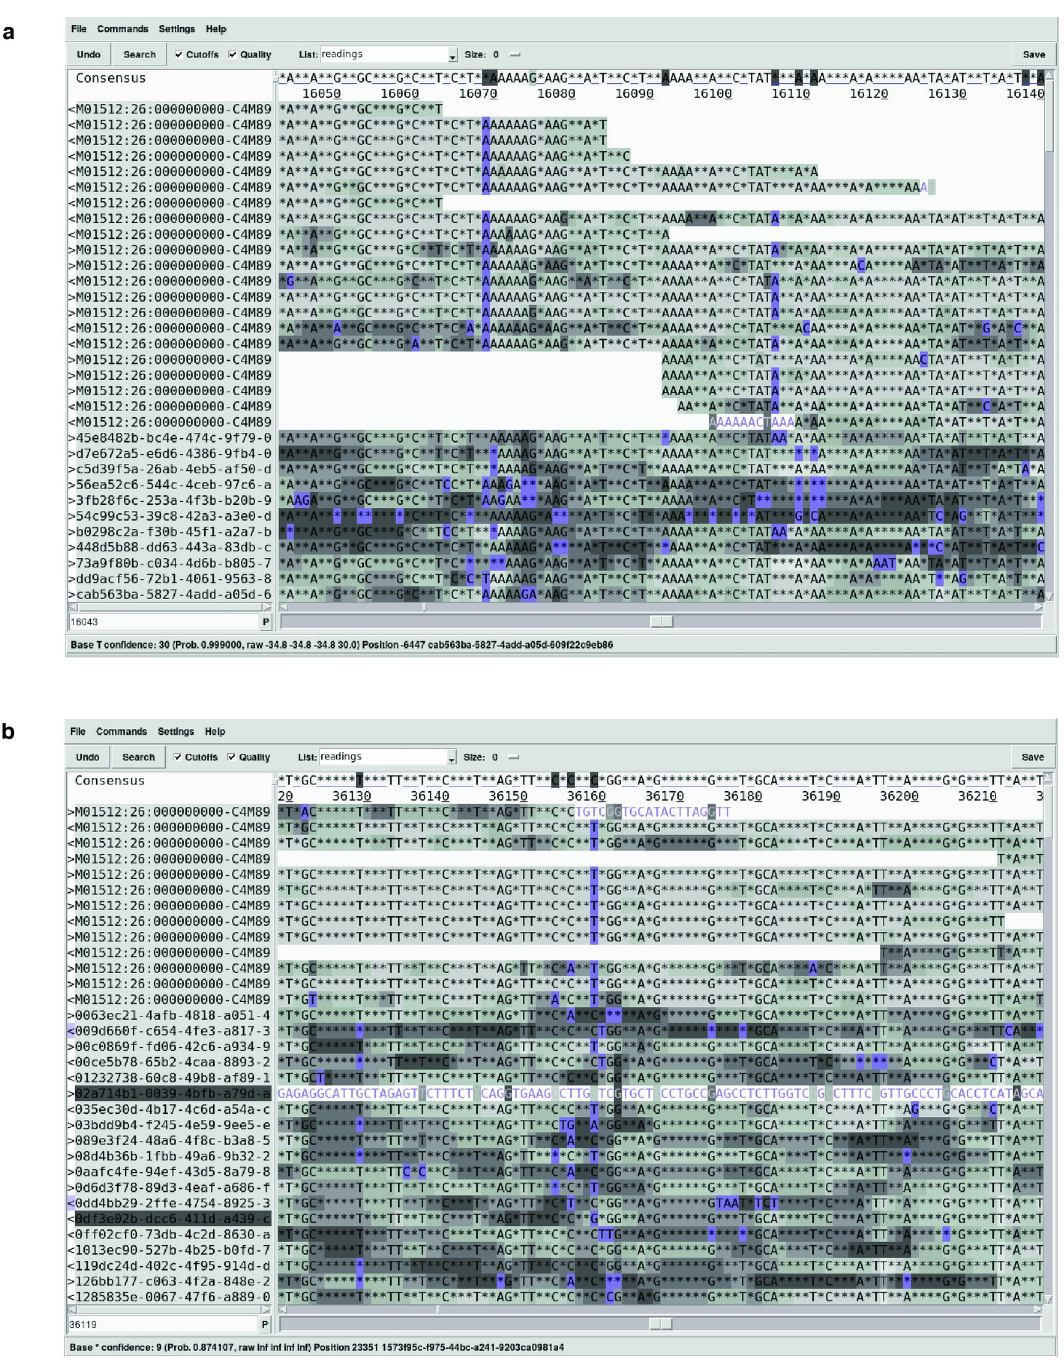
Fig 2. Editing clone assemblies in Gap5. Screenshots from Gap5 with reads sorted by technology (Illumina on top; nanopore on bottom), showing two instances where errors in the consensus can be resolved by correcting to the consensus of the Illumina reads: a) frequent insertion and deletion errors at homopolymer runs, and b) more rare substitution